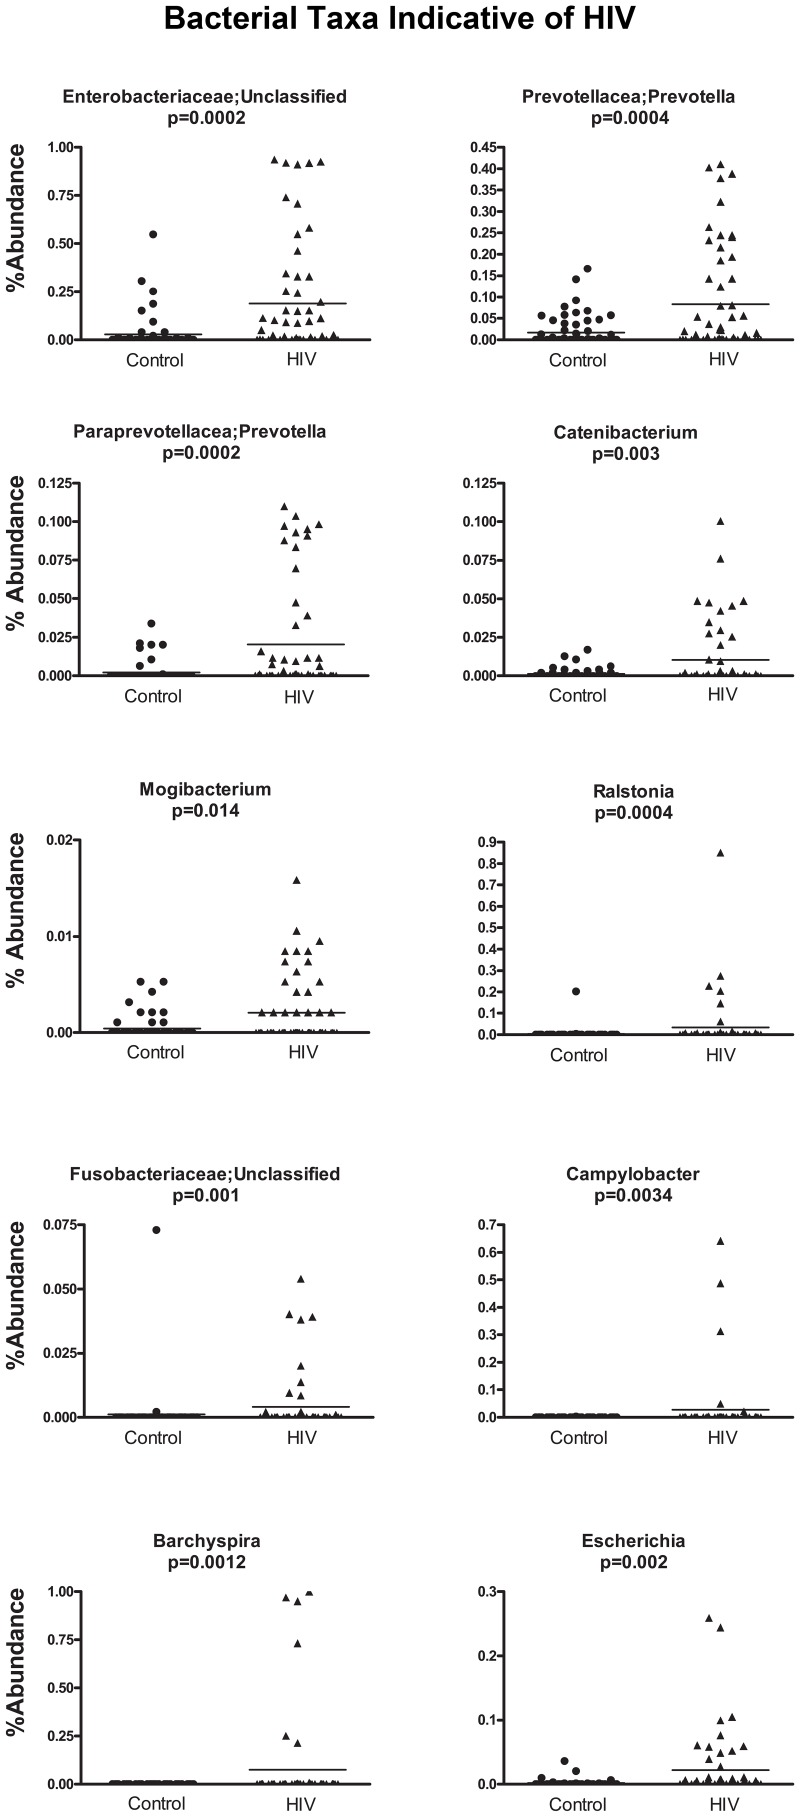
Scatterplots of bacterial taxa indicative of HIV samples.Y-axis shows percent abundance in rarified sequences for each sample. Control samples are shown as black dots and HIV samples are shown as upward black triangles. Horizontal lines denote mean value in each group. P-values shown are results from indicator species analysis. Genera and those unclassified bacterial members of families that not able to be classified down to a particular genus, that also have indicator values >15 and p<0.05 are shown.